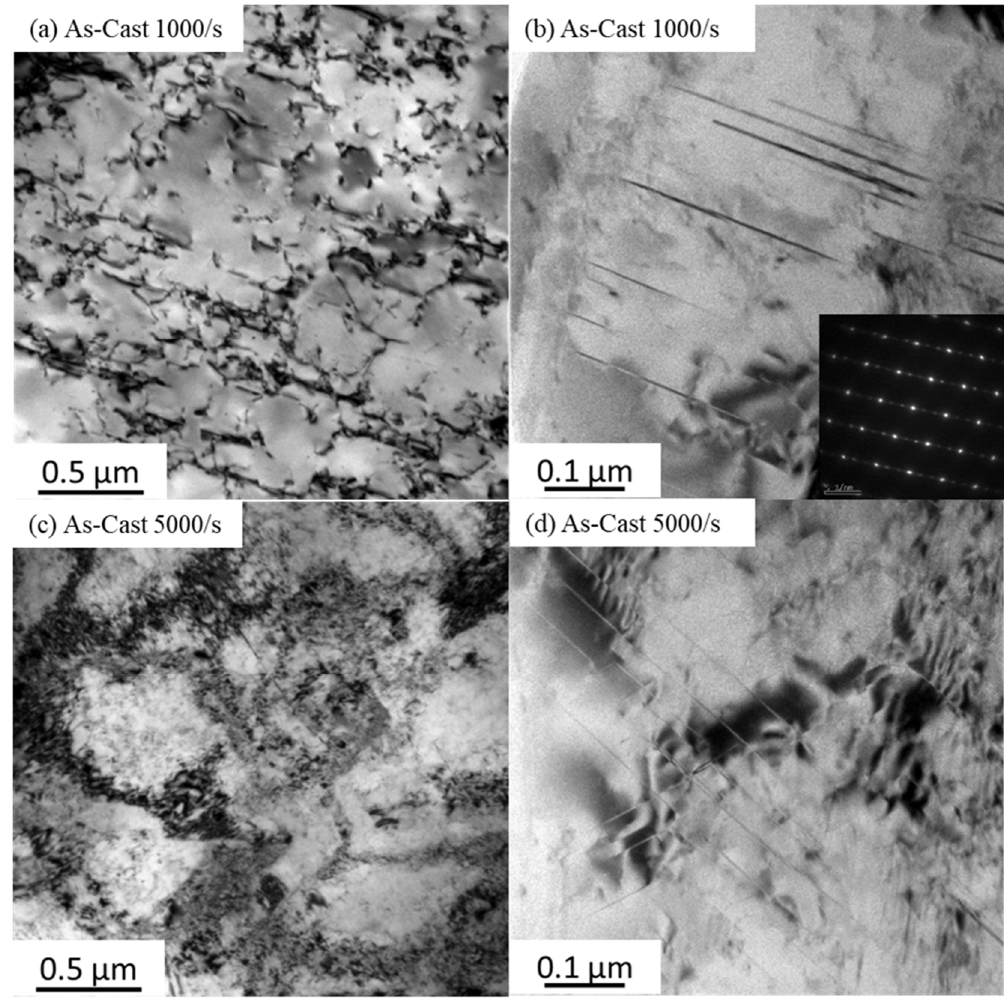
Figure 5. TEM images of the dynamic deformed As-Cast specimens. ( a ) Dislocations planar glide in 1000/s. ( b ) Nanoscale deformation twins in 1000/s. ( c ) High density dislocations in 5000/s. ( d ) Intersected nanotwins in 5000/s.